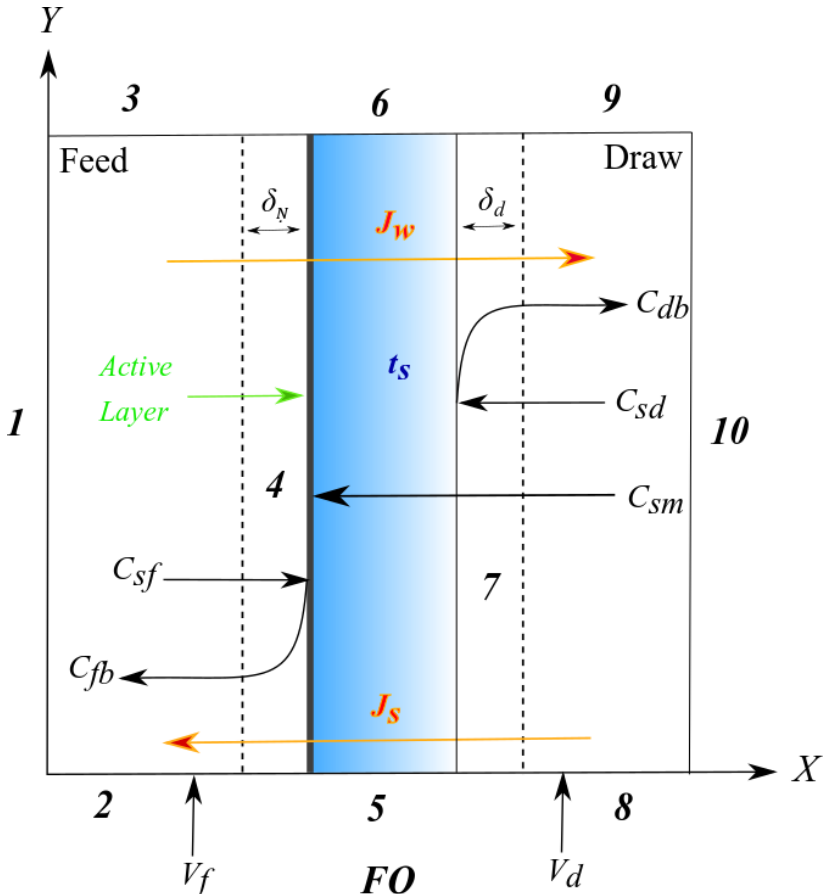
Figure 3. A schematic of the forward osmosis (FO) model diagram. Nomenclature: J w —water flux, J s —reverse salt flux, C —concentration, V —cross flow velocity, t s —porous thickness, δ —concentration polarization thickness; subscripts: m — membrane, d — draw, f — feed, b — bulk.